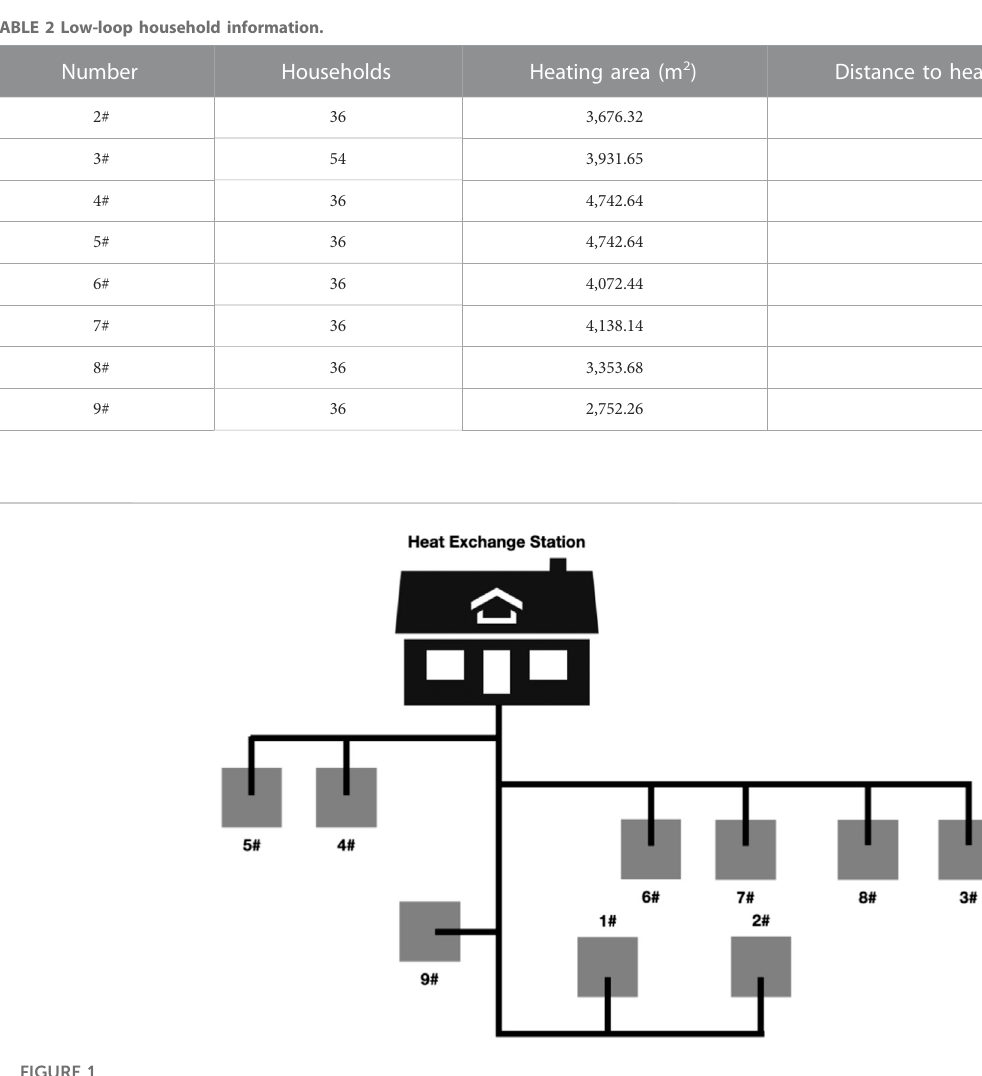
FIGURE 1 Heating system of outdoor pipe